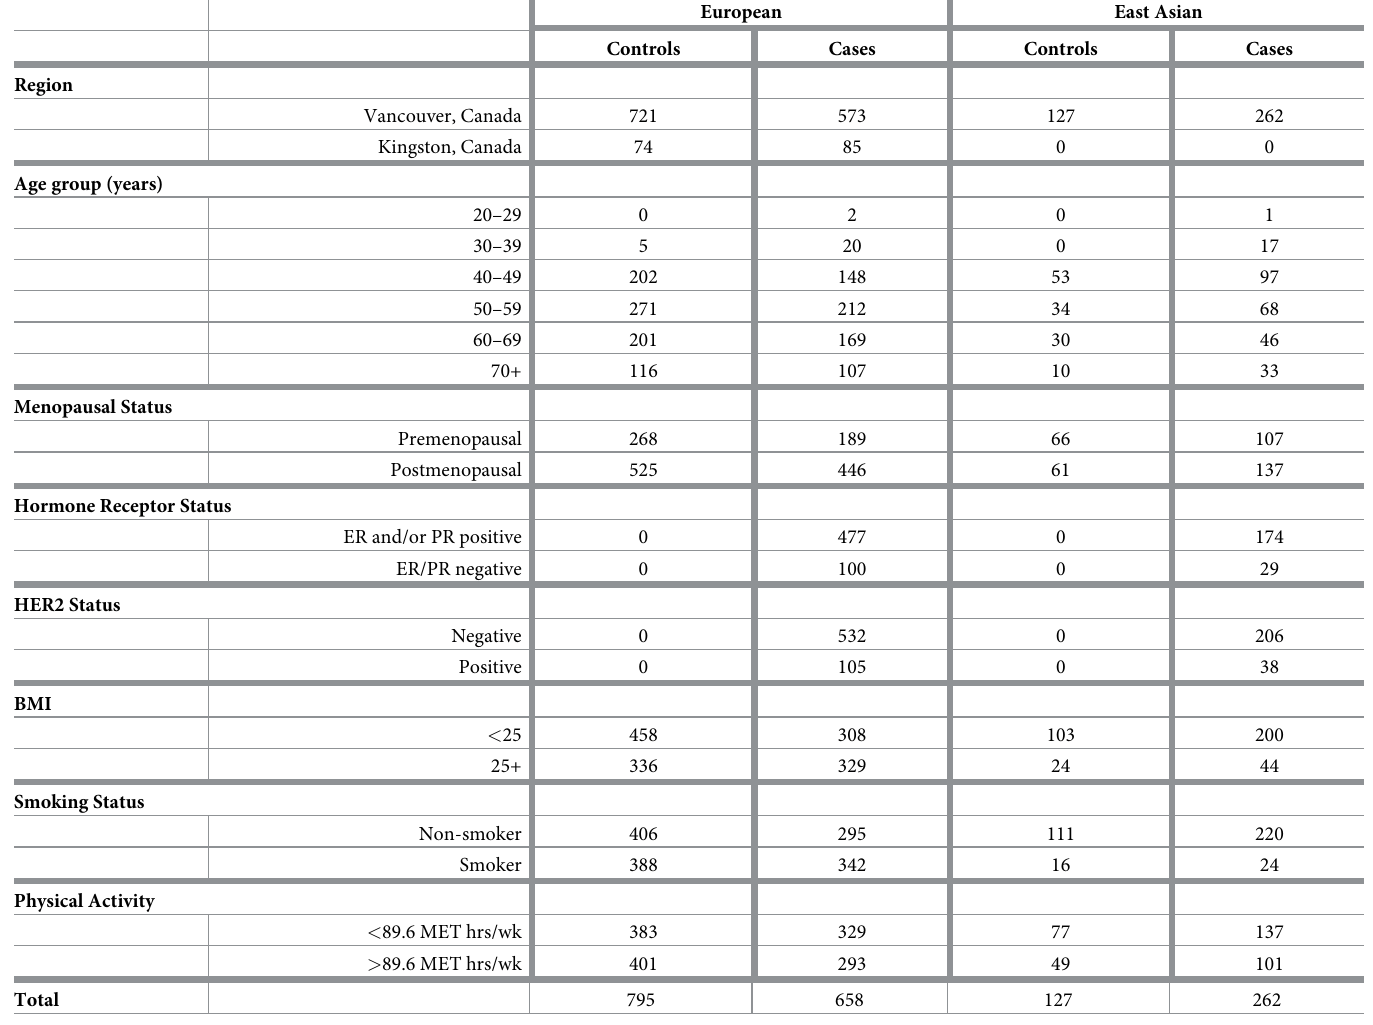
Table 2. Characteristics of participants whose samples passed quality